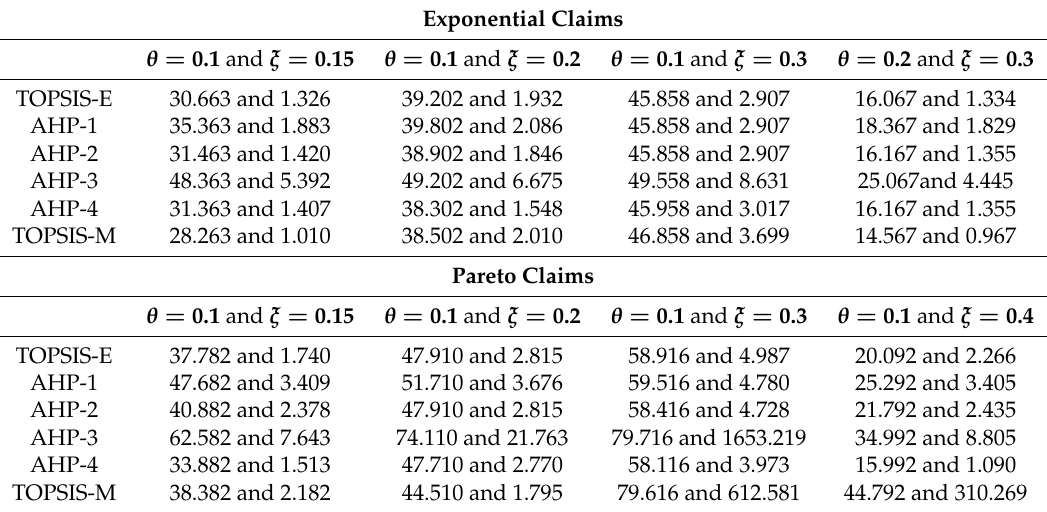
Table 8. Optimal pair of initial surplus and retention level under the TOPSIS and AHP methods. Exponential